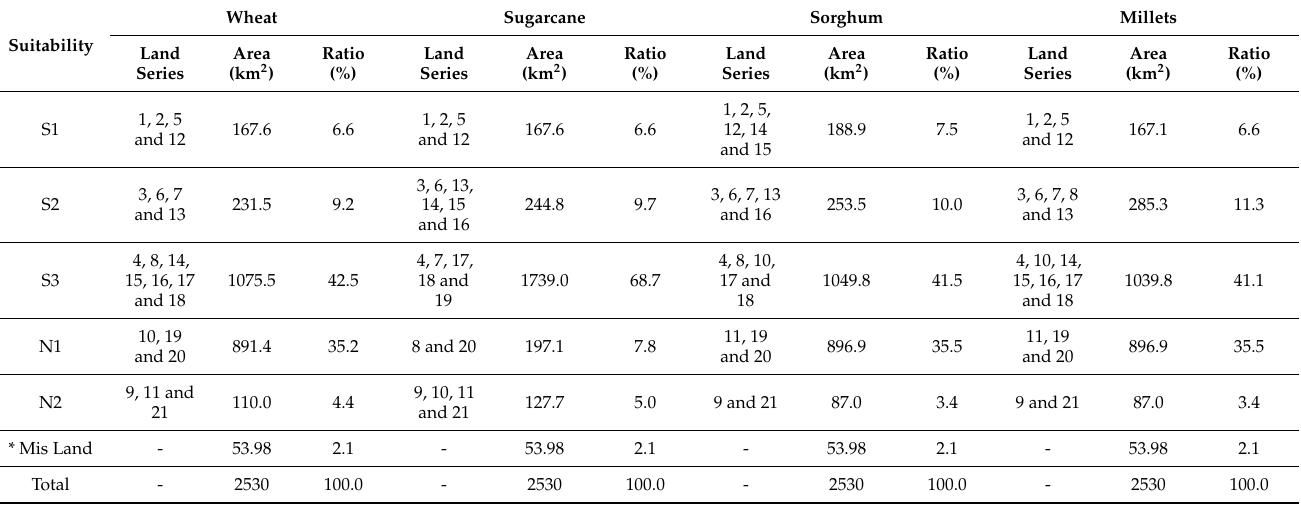
Table 5. Suitability for surface irrigation of wheat, sugarcane, sorghum, and millets distribution.